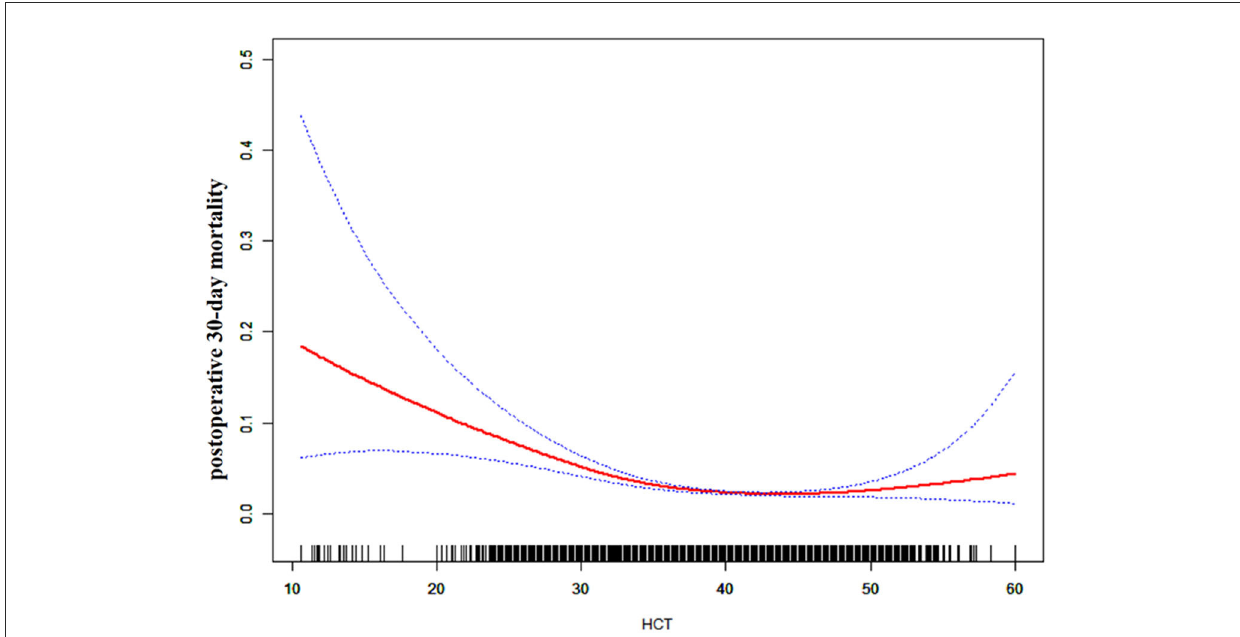
FIGURE2 The non-linear relationship between preoperative HCT and the risk of 30-day postoperative mortality (blue line: confidence interval, red line: postoperative 30-day mortality).